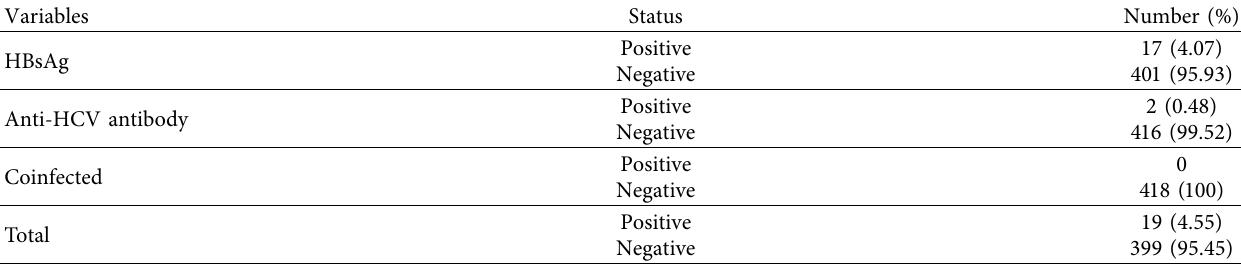
Table 3: Seroprevalence of HBV and HCV among voluntary blood donors at Bahir Dar Blood Bank centre, Northwest Ethiopia, 2020 ( n �